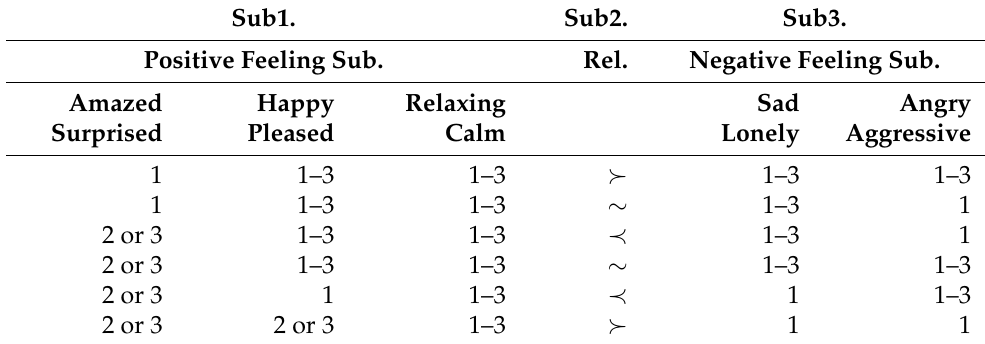
Table 3. The relation between positive and negative emotional subgroups. Sub1. Sub2. Sub3. Positive Feeling Sub.